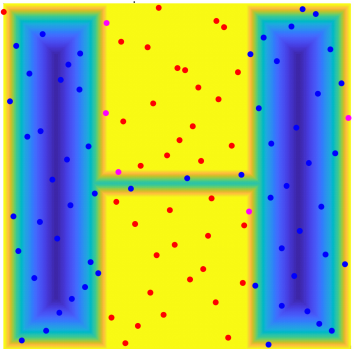
Figure 10. The distribution of sampling points in the potential energy map.